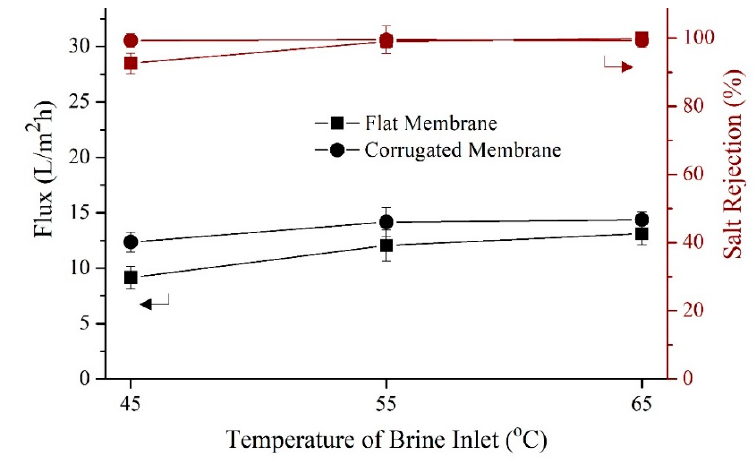
Figure 8. Performance of flat and corrugated membranes in treating brine solution (70 g/L of NaCl in DI water) at different feed temperatures. The cold stream was maintained at 25 °C. both cold and hot streams were pumped at a linear velocity of 2.2 cm/s.